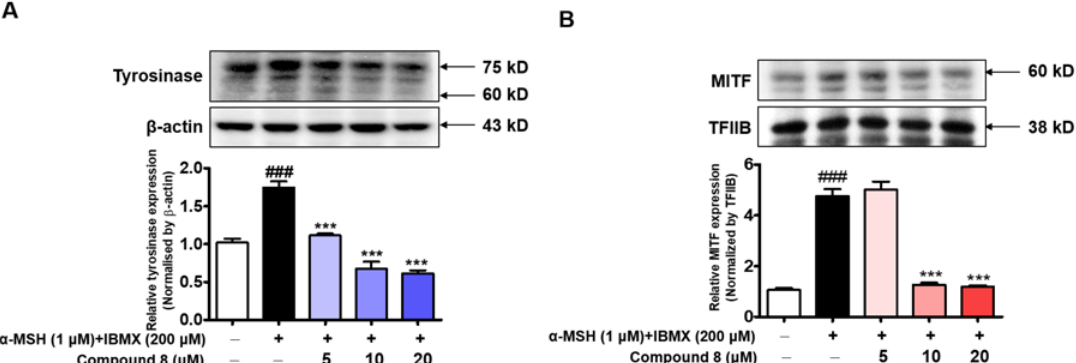
Figure 13. Effects of derivative 8 on the expression levels of tyrosinase ( A ) and microphthalmia- associated transcription factor (MITF) ( B ) proteins in stimulator- treated B16F10 cells. α -MSH (1 µM) plus IBMX (200 µM) was used as the stimulator, and cells were treated with three different concen- trations (5, 10, and 20 µM) of 8 . β -Actin and transcription factor IIB (TFIIB) were used as the loading controls for tyrosinase and MITF expression experiments, respectively. Data are represented as the mean ± SEM of three independent experiments. ### p < 0.001 vs. control. *** p < 0.001 vs. stimulator- treated cells.